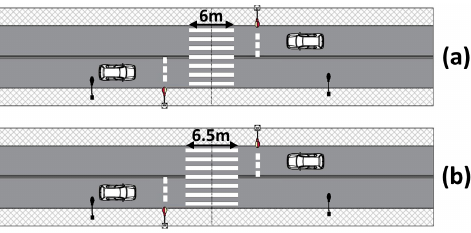
Figure 6. Scenario 3:( a ) the reference pedestrian crossing; ( b ) crossing width increased by 0.5 m relative to ( a ).